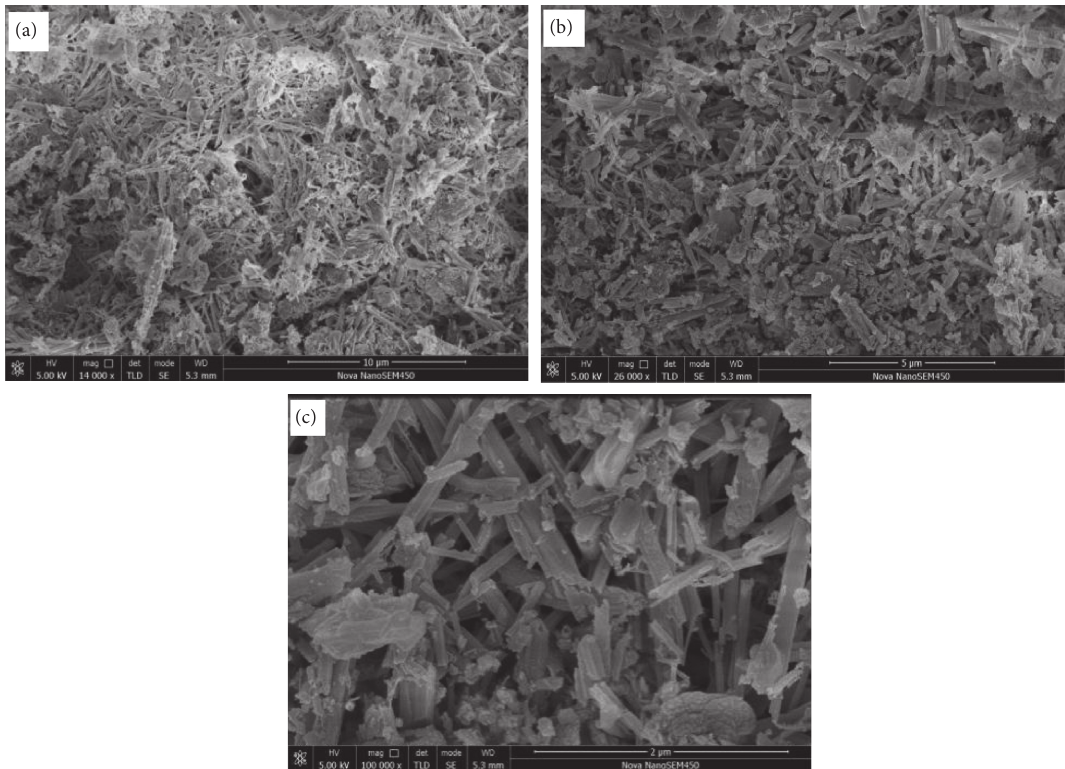
Figure 11: SEM images of the internal of 4-B-12: (a) 14000 times, (b) 26000 times, and (c) 100000